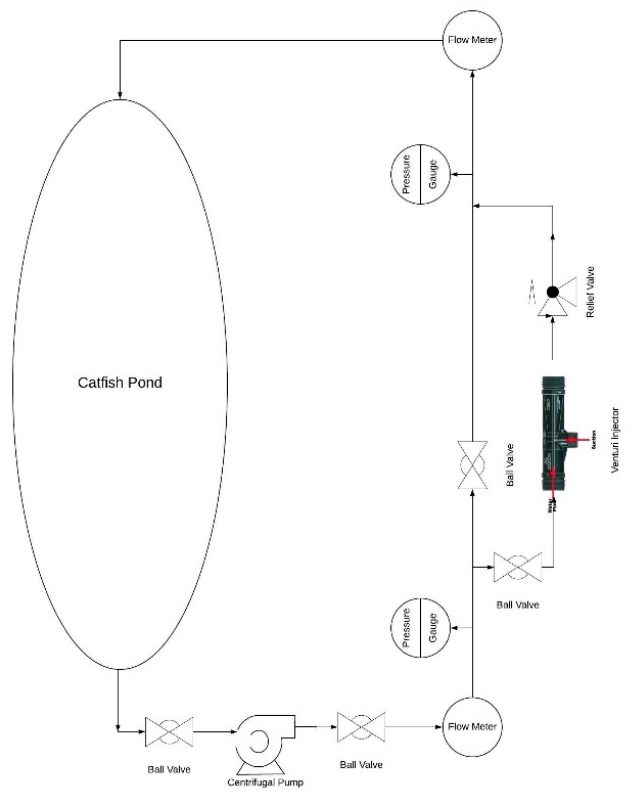
Figure 12. A schematic of the proposed system with one aerator. Table 6. E ffi ciency of di ff erent aeration